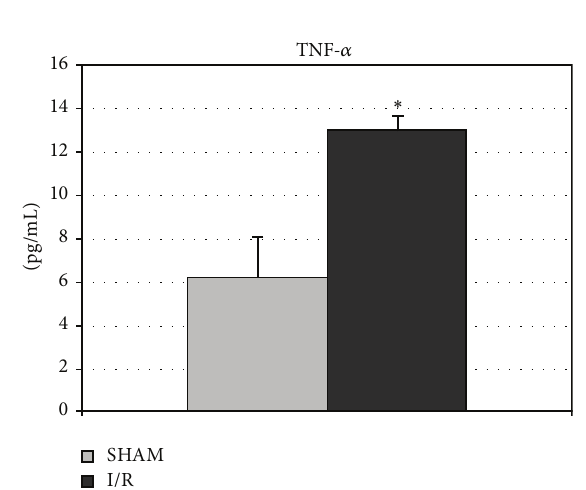
Figure 1: Serum levels of TNF- 𝛼 in animals submitted to ischemia/reperfusion (I/R). Sham operated group (control, 𝑛 = 15 ) has been compared with I/R group ( 𝑛 = 17 ): ∗ 𝑃 < 0.05 . These are the mean results of 32 different experiments ±